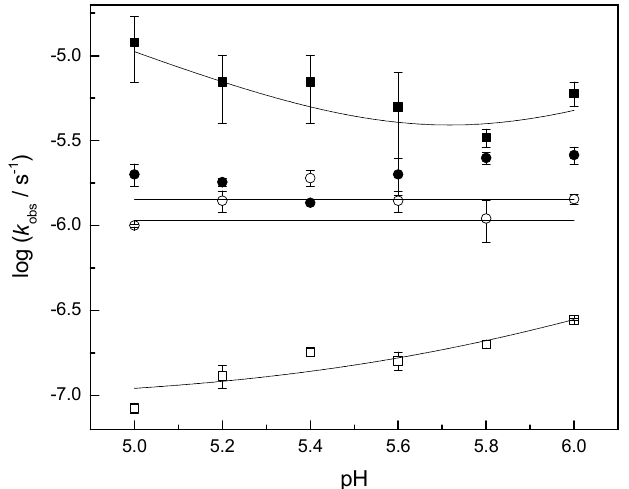
Figure 2. pH – rate profiles for the cleavage ( k 1 , squares) and isomerization ( k 2 + k − 2 , circles) of 1a in the absence (open symbols) and presence (filled symbols) of Hg(II); T = 90 °C; [Hg(II)] = 0/5 mM; [buffer] = 30 mM; I (NaNO 3 ) = 100 mM. Table 2. Rate constants for the partial reactions contributing to the cleavage and isomerization of 1a and 1b ; T = 90 °C; [Hg(II)] = 0/5 mM; [buffer] = 30 mM; I (NaNO 3 ) = 100 mM.